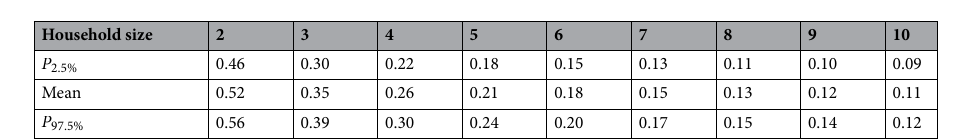
Table 2. Household pairwise susceptible-infectious transmission probability for household sizes 2–10 with 95% confidence